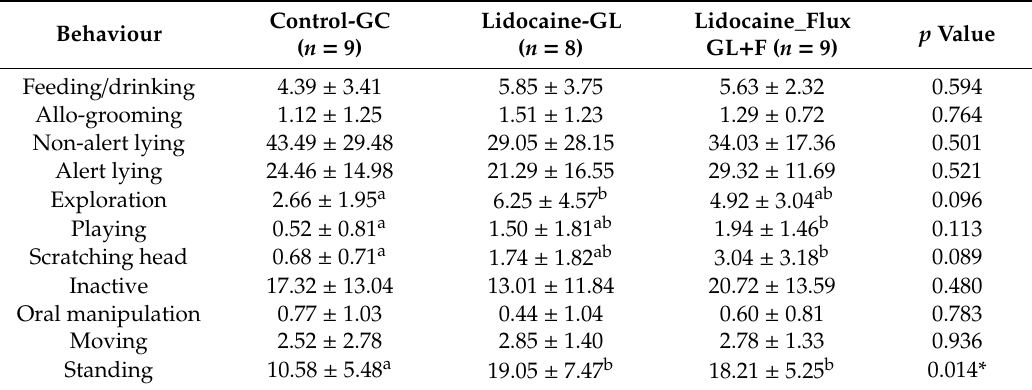
Table 2. Average percentage ( ± SD) of the time of manifestation of each state behaviour in the three treatments during the observation period, and relative levels of significance of the di ff erences. Significance: * p < 0.05; letters (a and b) on the same line indicate statistically significant di ff erences (LSD test).